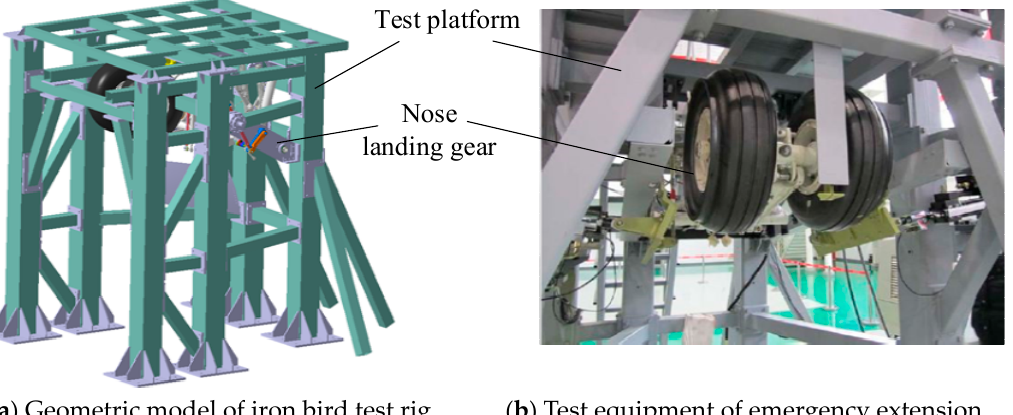
Figure 9. Sketch map of iron bird test system.